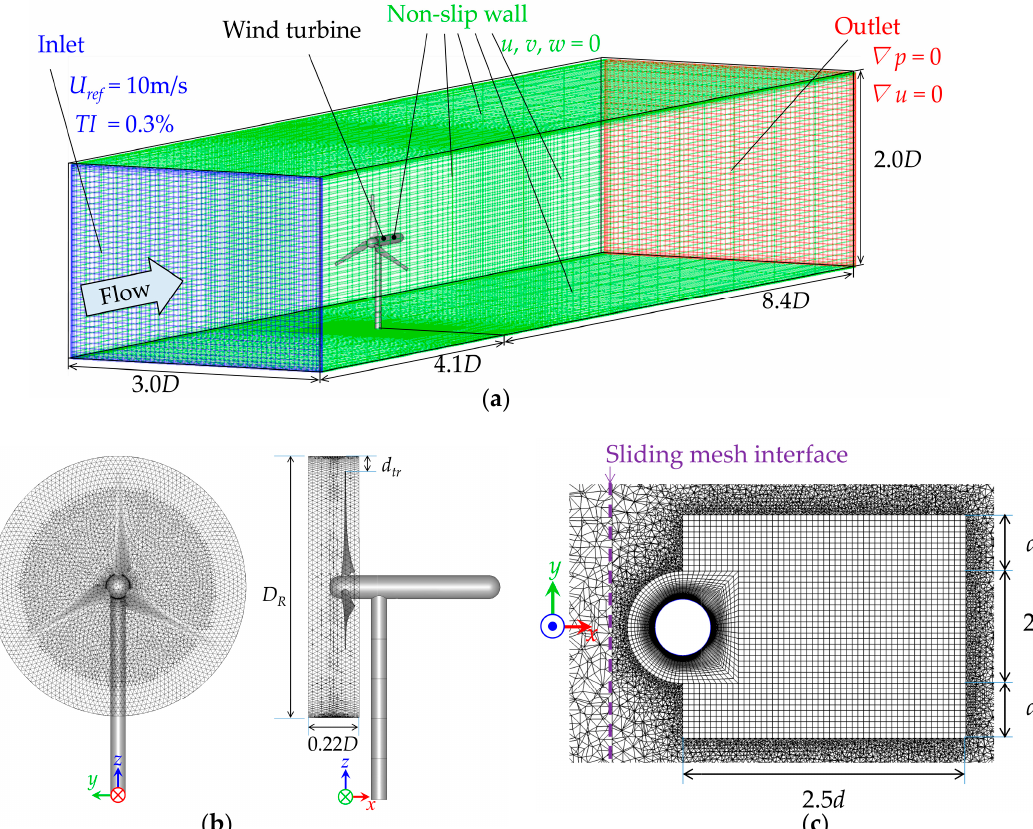
Figure 2. Computational grid and boundary conditions. ( a ) Entire computational domain; ( b ) rotational domain; and ( c ) horizontal cross-section of the grid near the tower at the mid-height of Segment 3.